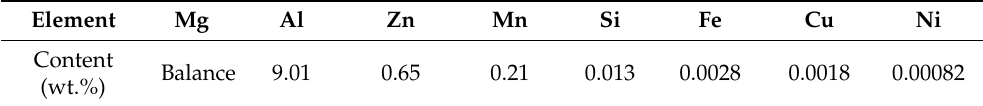
Table 1. Element content of AZ91D magnesium